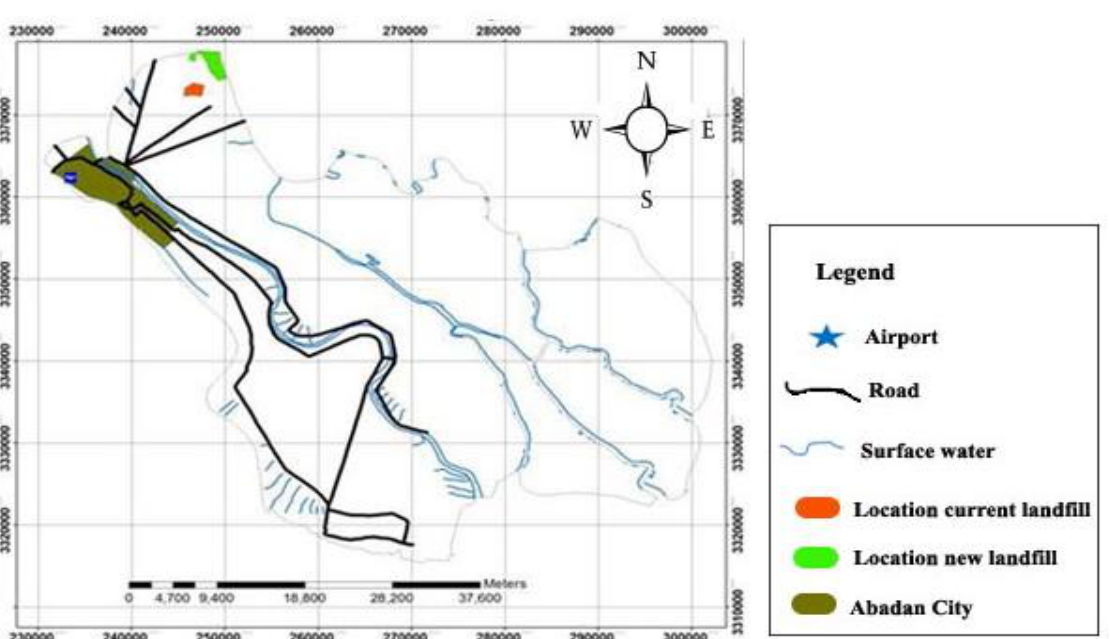
Fig. 11: the final map of the location of waste disposal site using the hierarchy